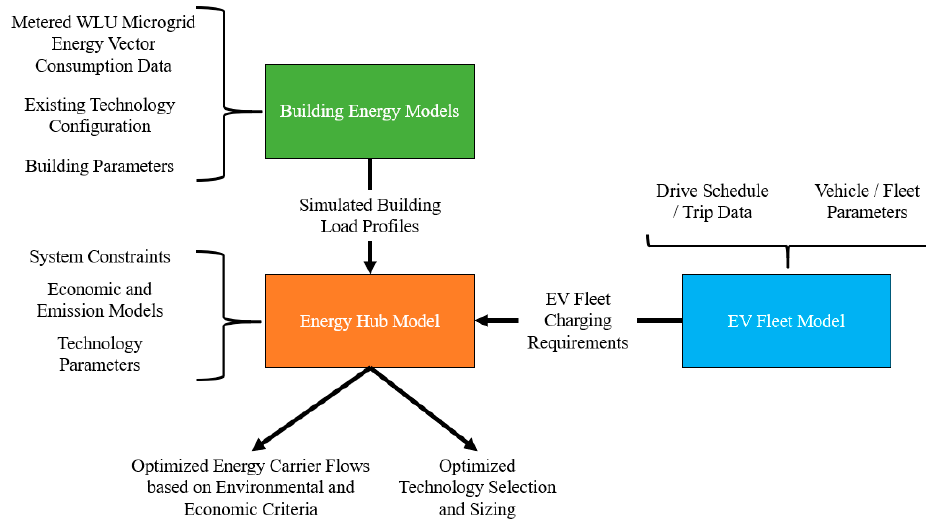
Figure 1 . Holistic representation of multi-component simulation approach. EV—electric vehicles. Figure 1. Holistic representation of multi-component simulation approach. EV—electric